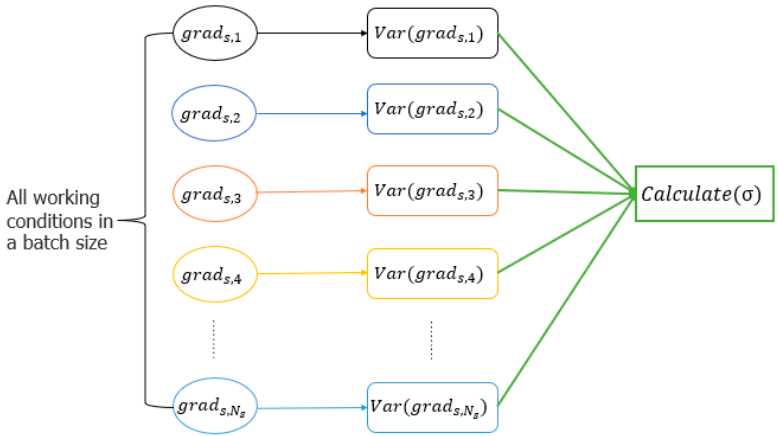
Figure 2. SAND ‐ Mask Calculates σ in a batch Figure 2. SAND-Mask Calculates σ in a